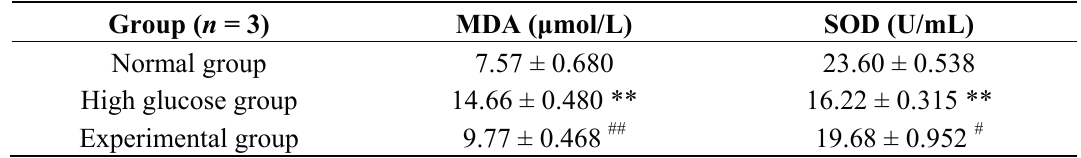
Table 2. Effect of GA on model driven architecture (MDA) and SOD in NRK-52E